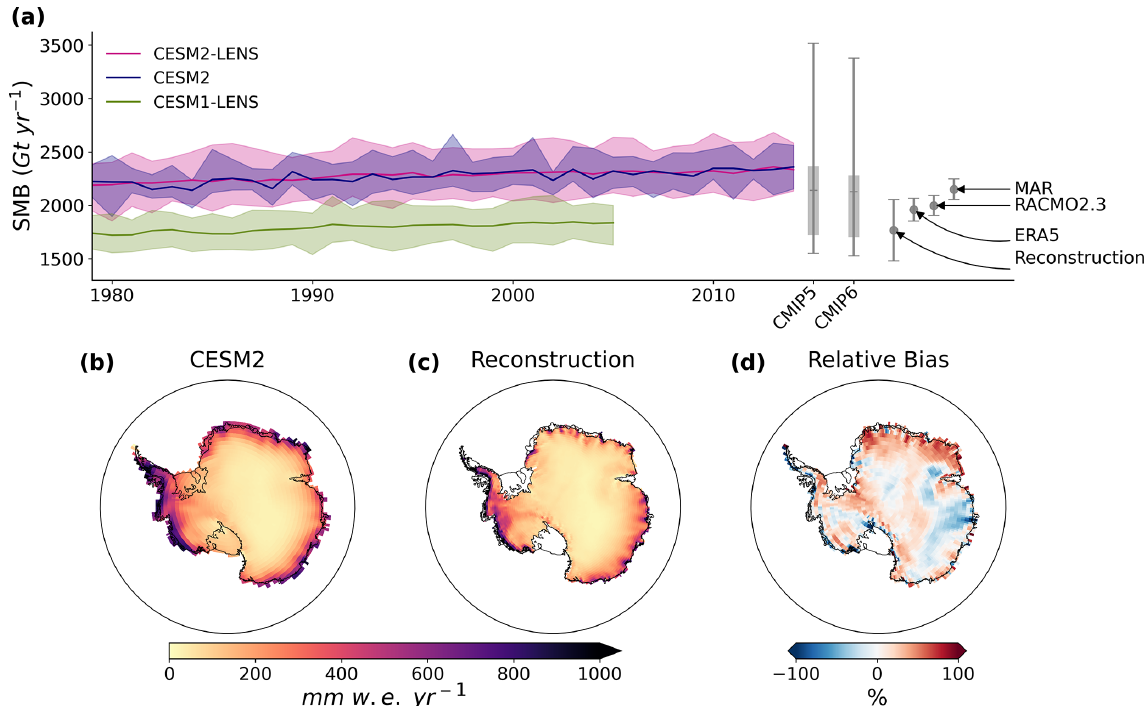
Figure 6. Modeled AIS SMB. (a) 1979–2015 time series of annual grounded AIS SMB from CESM2-LENS, CESM2, and CESM1-LENS with the ensemble mean plotted with the solid line and the ensemble spread shaded. The average annual SMB spread for all CMIP5 and CMIP6 models is shown on the right with grey box-and-whisker plots. Also shown is the average annual SMB from the MT2019 recon- struction with error bars representing reconstruction error and the average annual SMB from MAR, RACMO2.3, and ERA5 with error bars representing ± 1 standard deviation. (b) 1979–2015 annual AIS SMB from CESM2. (c) 1979–2000 annual AIS SMB from the MT2019 reconstruction. (d) Relative bias between CESM2 and MT2019 reconstruction